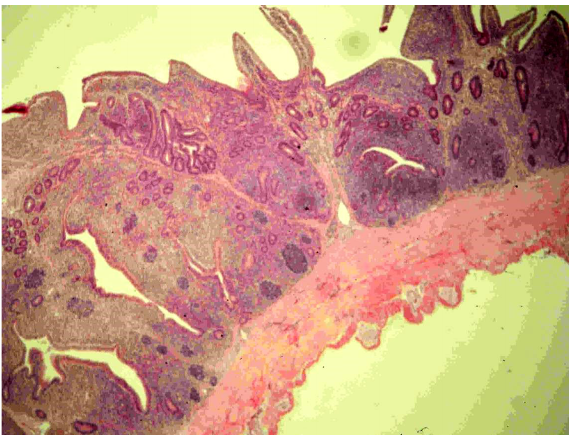
Fig. 11. Broiler chickens caecal tonsil, the 2 nd group, the 30 th day. H&E. x 50